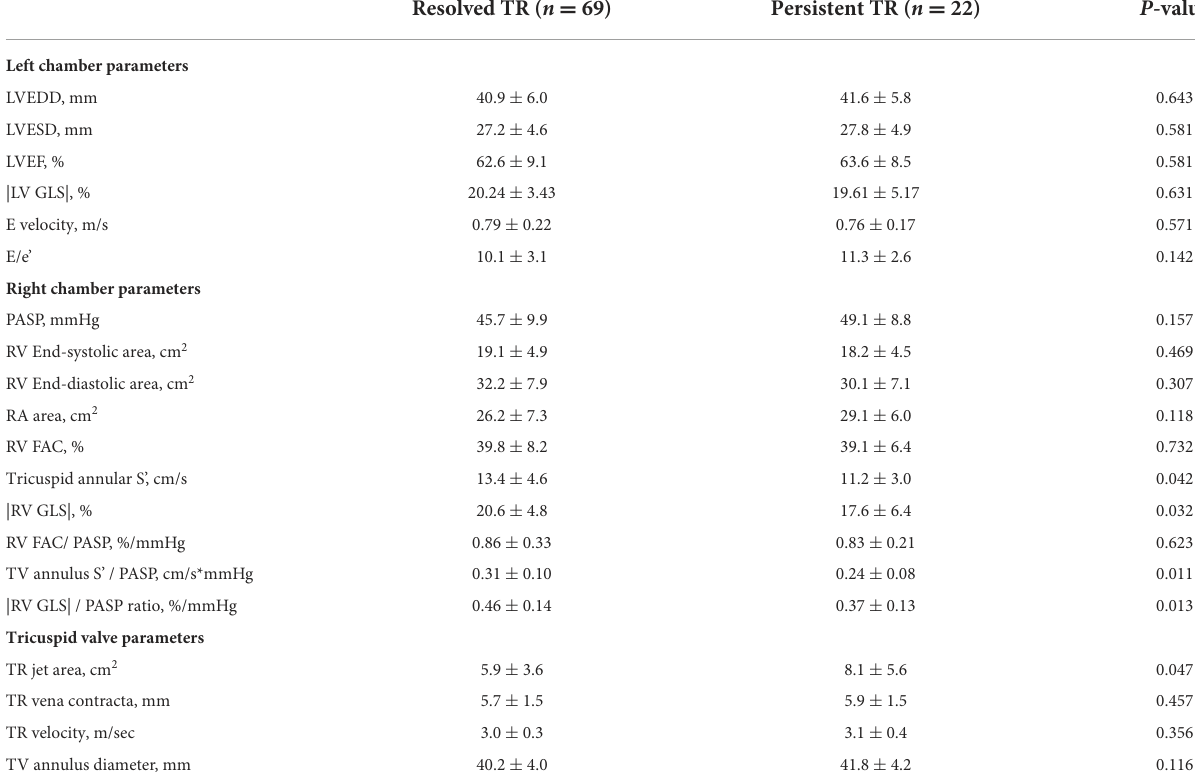
TABLE 3 Comparison of two groups based on the resolution or persistence of